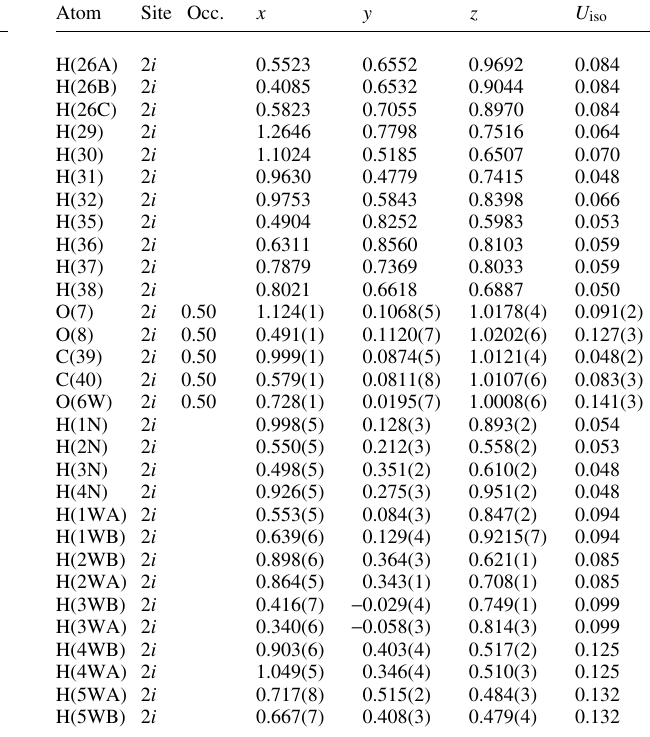
Table 2. Atomic coordinates and displacement parameters (in Å 2 ) . Atom Site